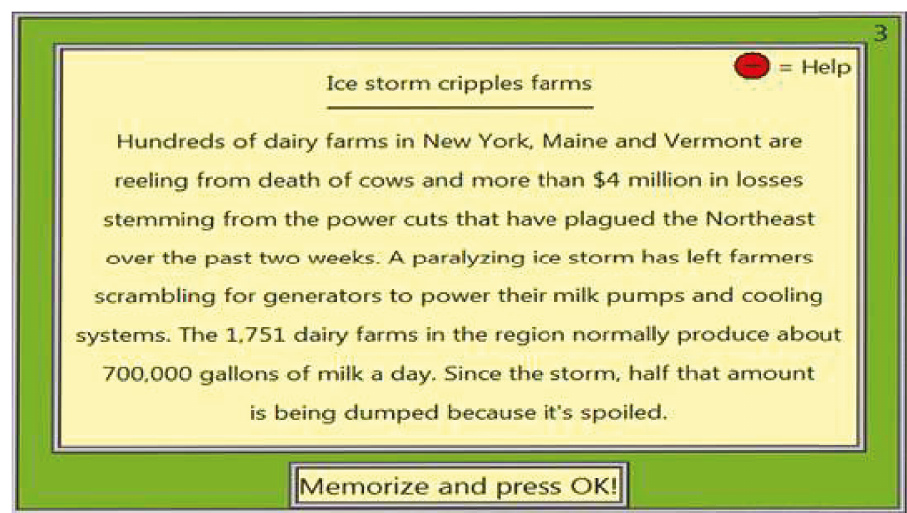
Figure 7: Example of training on level 3, of the verbal memory RehaCom module.